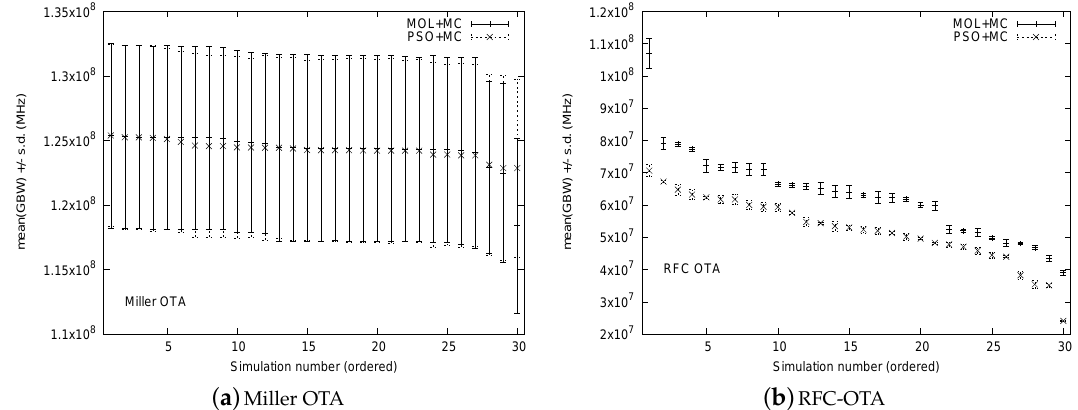
Figure 7. Mean and standard deviation of the Monte Carlo simulation for all the 30 optimization runs.